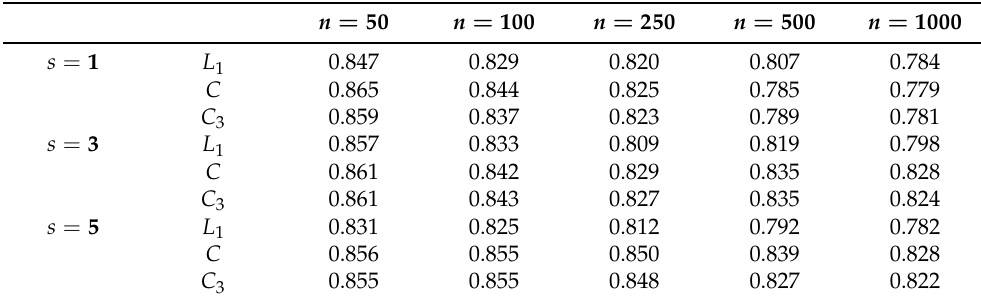
Table 3. The excess risk of the L 1 , Catoni, and third-moment Catoni regression estimator on a skewed normal distribution. n = 50 n = 100 n = 250 n = 500 n =